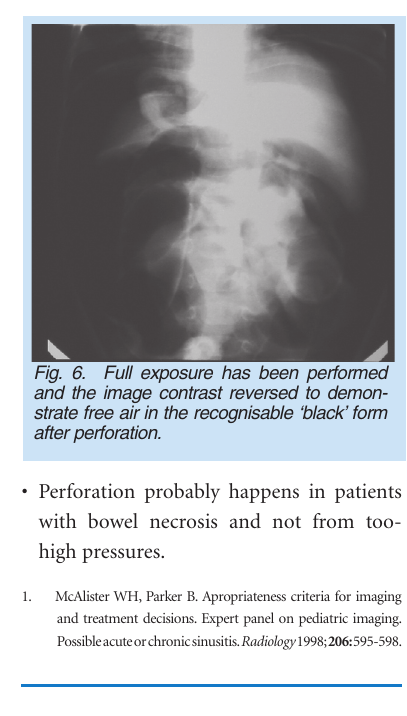
Fig. 2. We recommend this preliminary film which shows the amount of central gas prior to reduction attempt and is a valuable record when the free flow into the small bowel is not actually visualised.